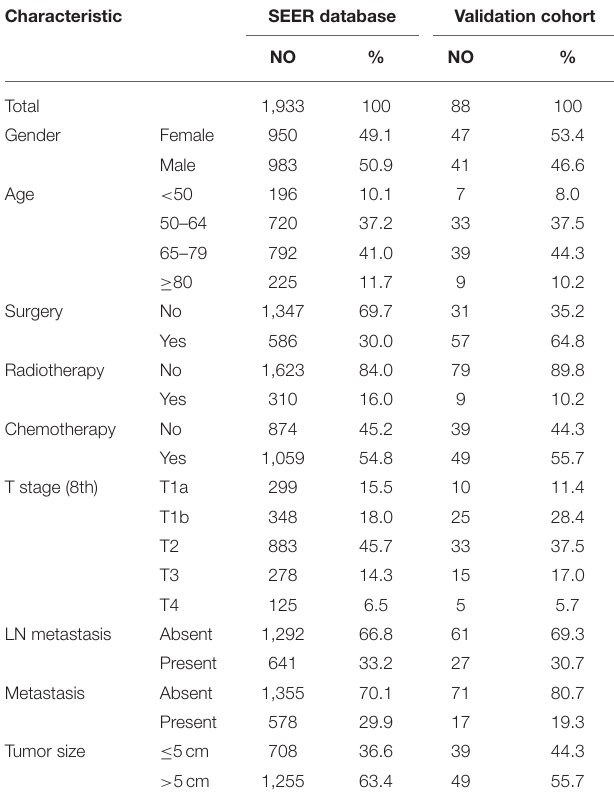
TABLE 1 | Clinical characteristics of patients in the SEER database and external validation